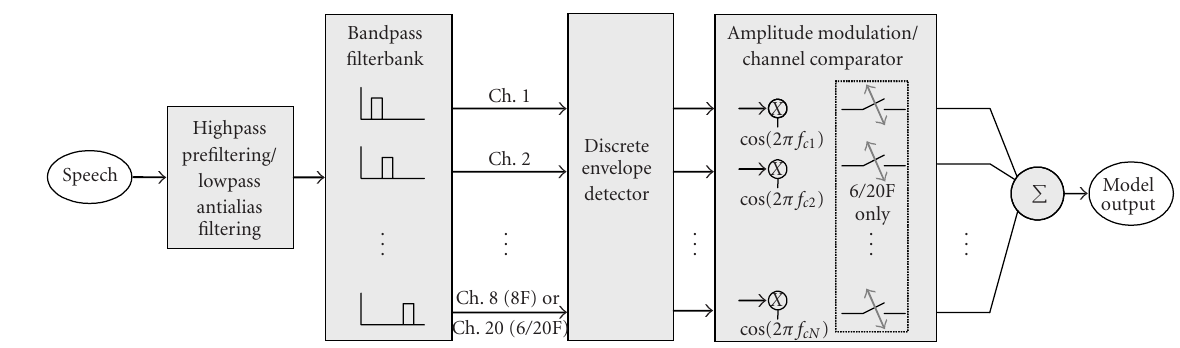
Figure 1: Block diagram of acoustic model. Temporal resolution is equivalent in both models, with channel envelopes discretized over 2- millisecond windows. In each 2-millisecond window, the 8F model presents speech information from 150 Hz to 6450 Hz divided amongst eight channels, whereas the 6/20F model presents six channels, each with narrower bandwidth, chosen from twenty channels spanning 250 Hz to 10823